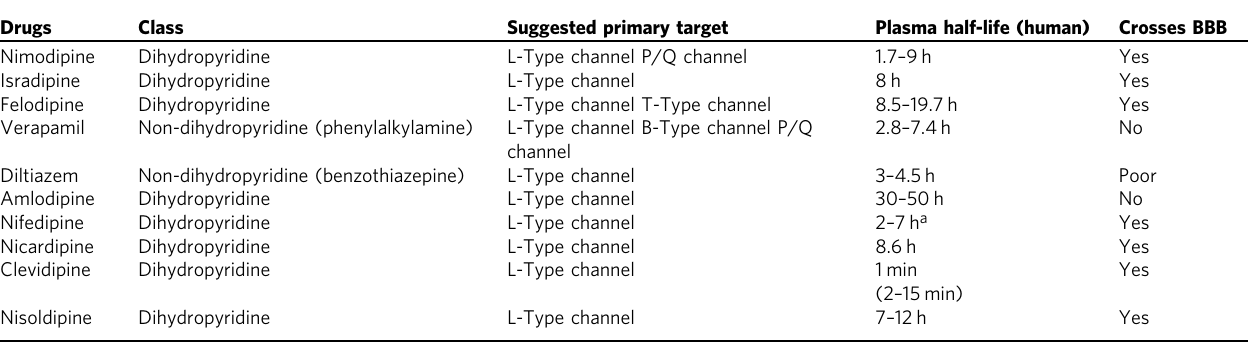
Table 1 List of selected calcium channel blockers